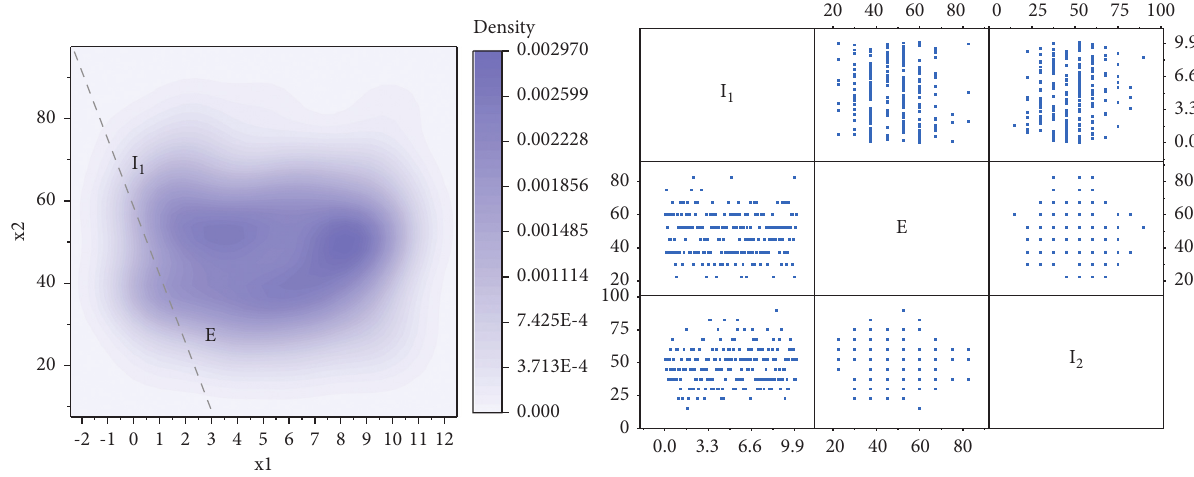
Figure 5: Contour through Nash equilibrium point E